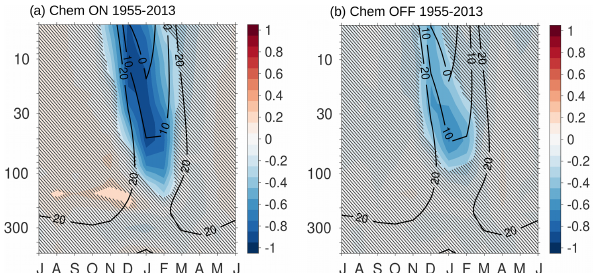
Figure 3. Correlations between ozone at 50hPa and dynamical heating rates for (a) Chem ON and (b) Chem OFF as a function of height for 1955 to 2013 (shading). The particular climatolog- ical zonal mean zonal wind (contours) is represented for values 20 ≤ ms − 1 for the same period with an interval of 10ms − 1 . In the non-hatched area more than half of the ensemble members (at least five out of nine members) show significant correlation coefficients with p values ≤ 0 .